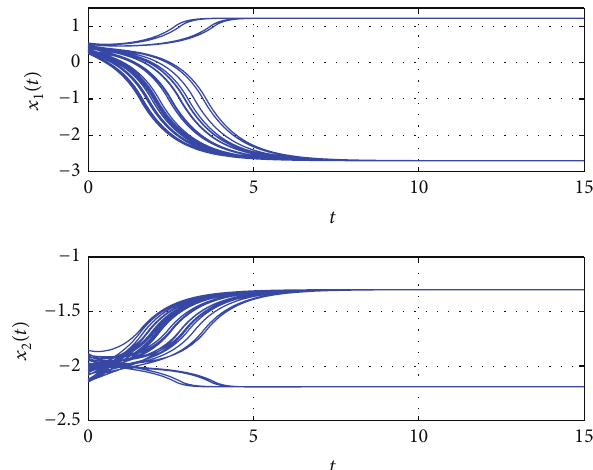
Figure 4: Transient behavior of 𝑆 1 and 𝑆 2 in Example 1.